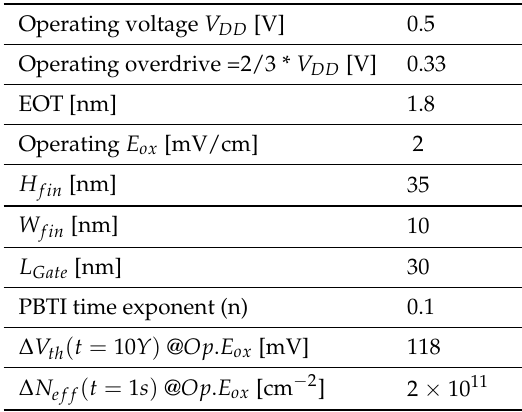
Table 1. Device parameters for Indium-Gallium-Arsenide ( InGaAs )-based High Electron Mobility Transistors (HEMT) as per the experimental results